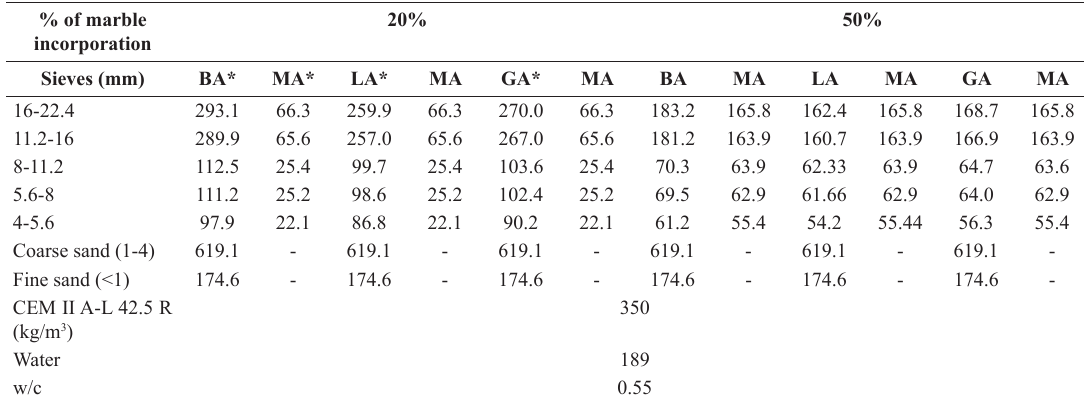
Table 2. Composition of CMA mixes (per m 3